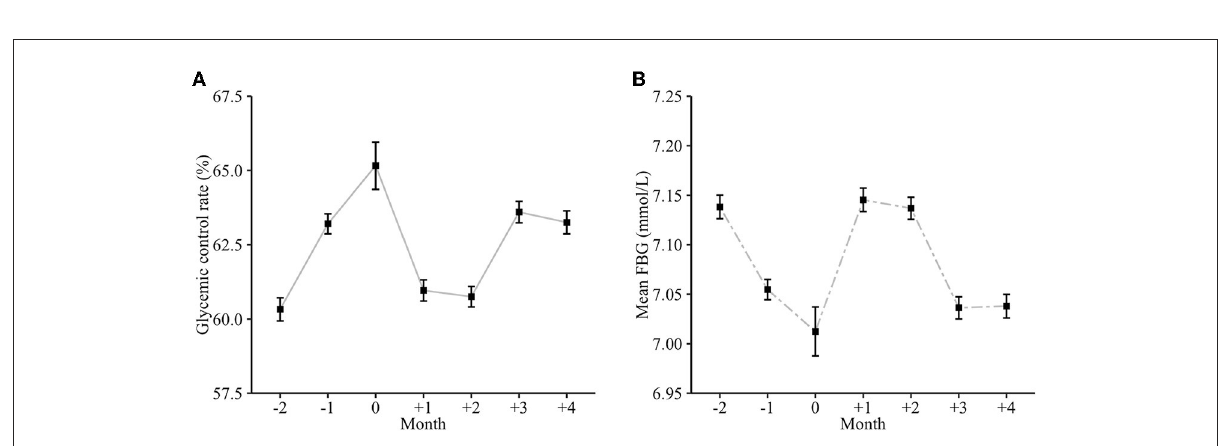
FIGURE3 The monthly glycemic trend around the Chinese Spring Festival. (A) Glycemic control rate; (B) Mean FBG.